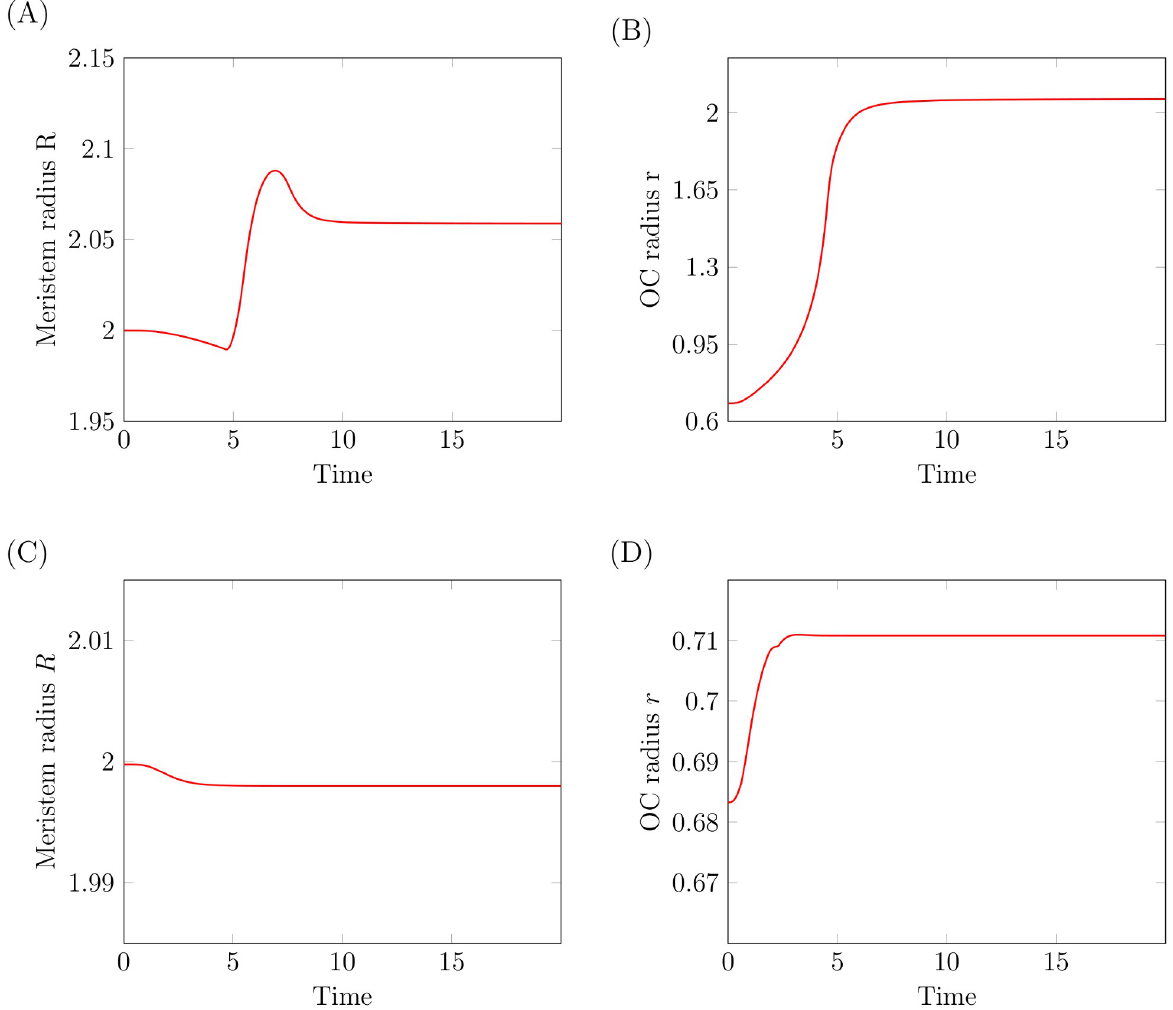
Fig 8. Direct effect of HEC on OC cells. Simulation of HEC over-expression with (A-B) and without (C-D) a direct effect of HEC on OC cell differentiation. (A-B) Time evolution of meristem and OC radius during HEC over-expression in stem cells. The simulations assume a direct effect of HEC on OC cells. (C-D) Time evolution of meristem and OC radius during HEC over-expression in stem cells. The simulations assume no direct effect of HEC on OC cells. Unlike in the experiments the WUS expressing domain does not extend over the whole meristem. For all depicted simulation we set c =